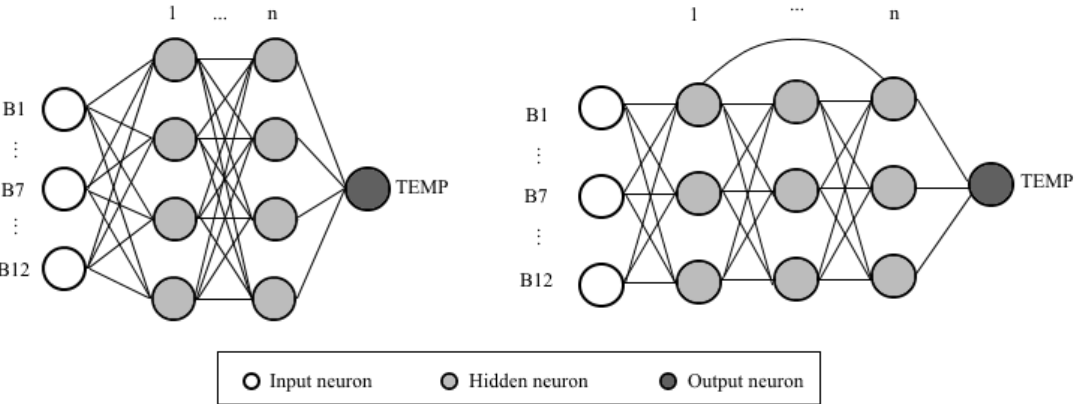
Figure 3. Schematic of the structures of neural networks used in the paper with temperature as example output. Deep Neural Network ( left ) and Deep Neural Network with shortcuts ( right ). The sketches represents networks with n layers fully connected; the input neurons are the variables summarised in Tables 4 and 5— note that band QA60 has not been used as input for the Neural